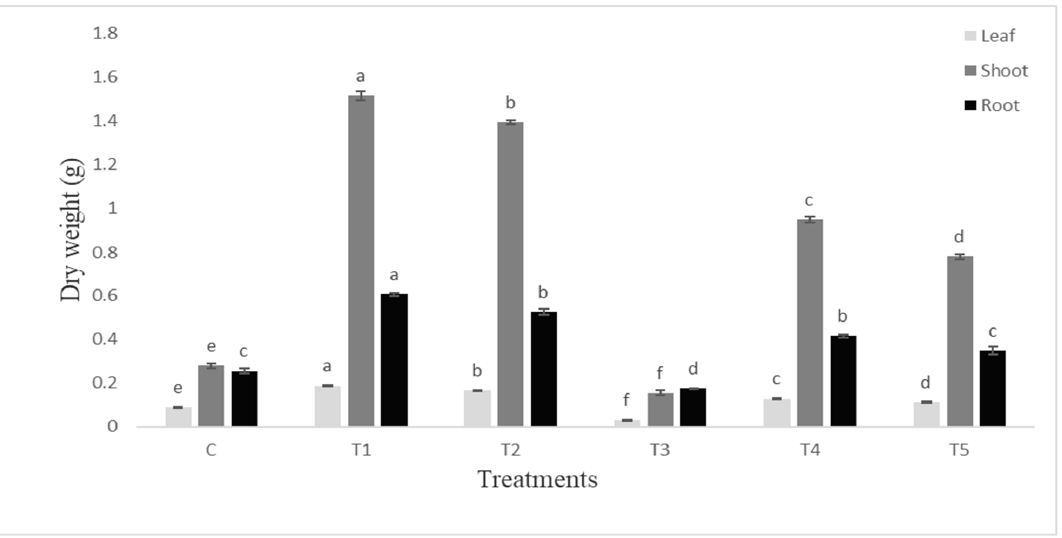
Figure 4. Dry weight of leaf, shoot and root (g) of tomato plant infested with S. litura and under control condition. Data are means of four replicates along with standard error bars. Different letters are indicating significant differences ( p < 0.05) among treatments.